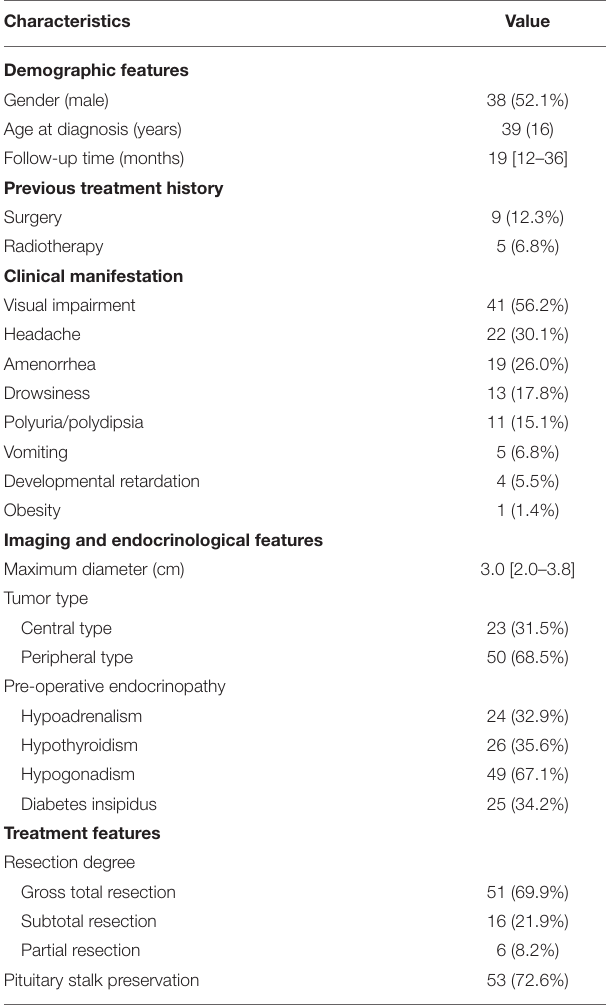
TABLE 1 | Clinical characteristics of 73 patients with suprasellar